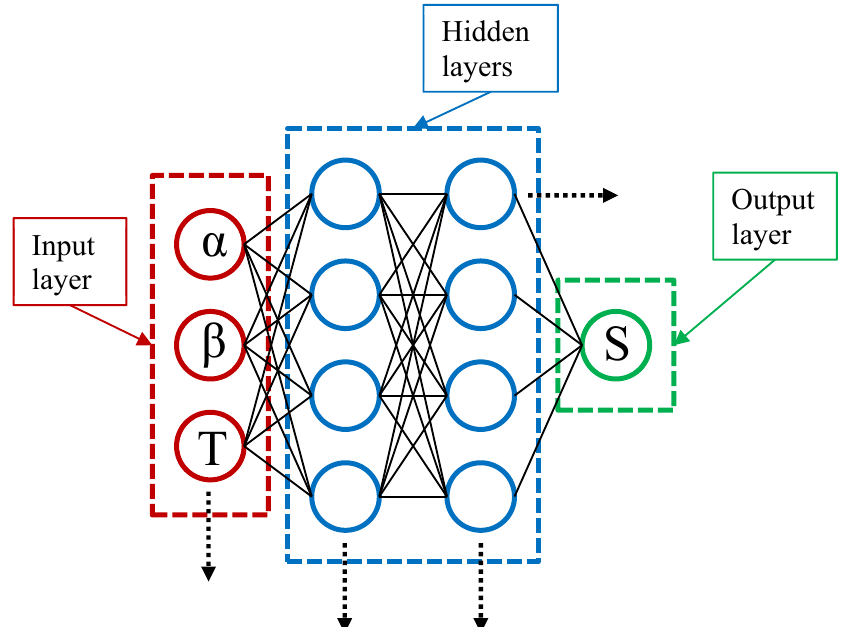
Figure 1. Representative FNN in this work with three (or more) inputs, one output, and numerous hidden